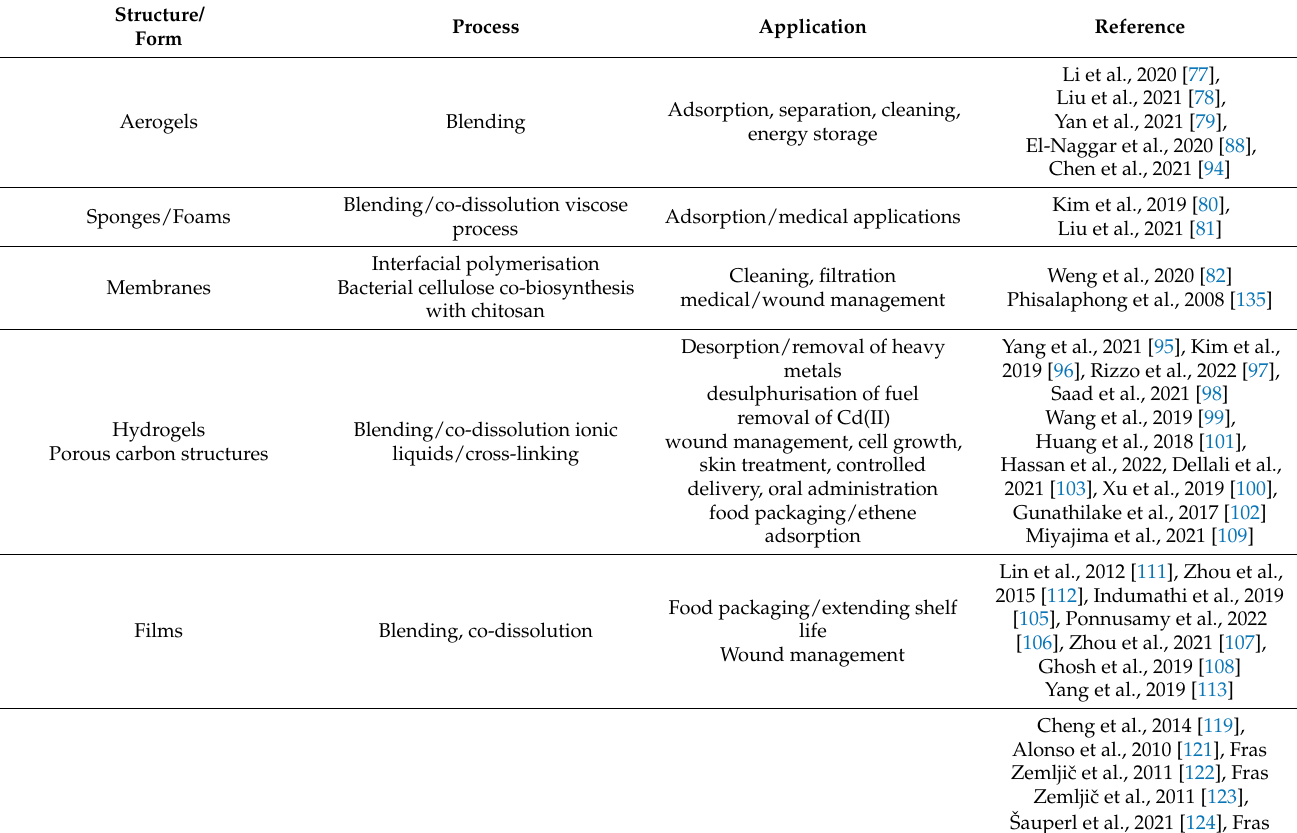
Table 1. An overview of the research and development of structures and preparation processes of cellulose–chitosan biocomposites and their potential